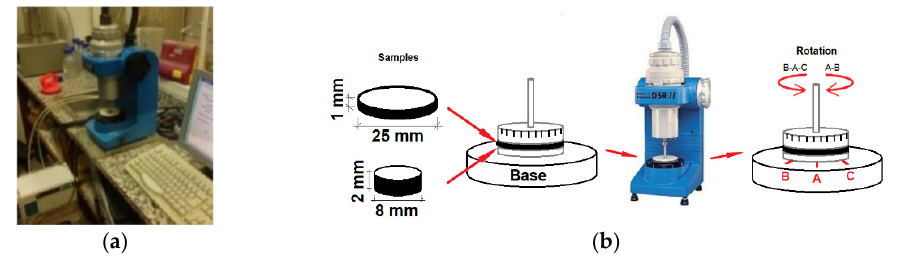
Figure 3. Dynamic rheology: ( a ) dynamic shear rheometer; ( b ) its operating mode.